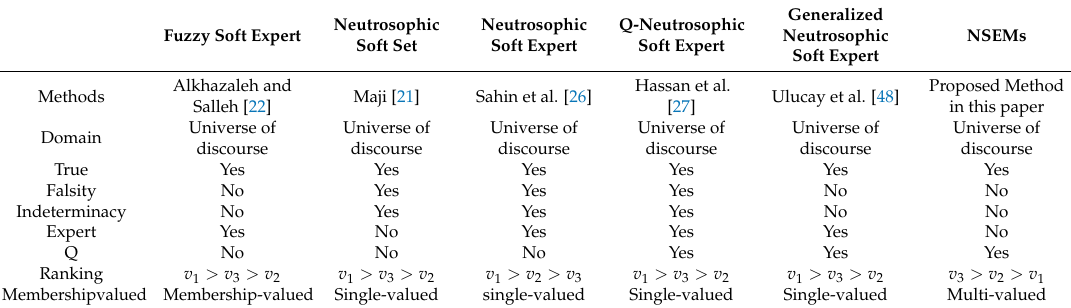
Table 5. Comparison of fuzzy soft set and its extensive set